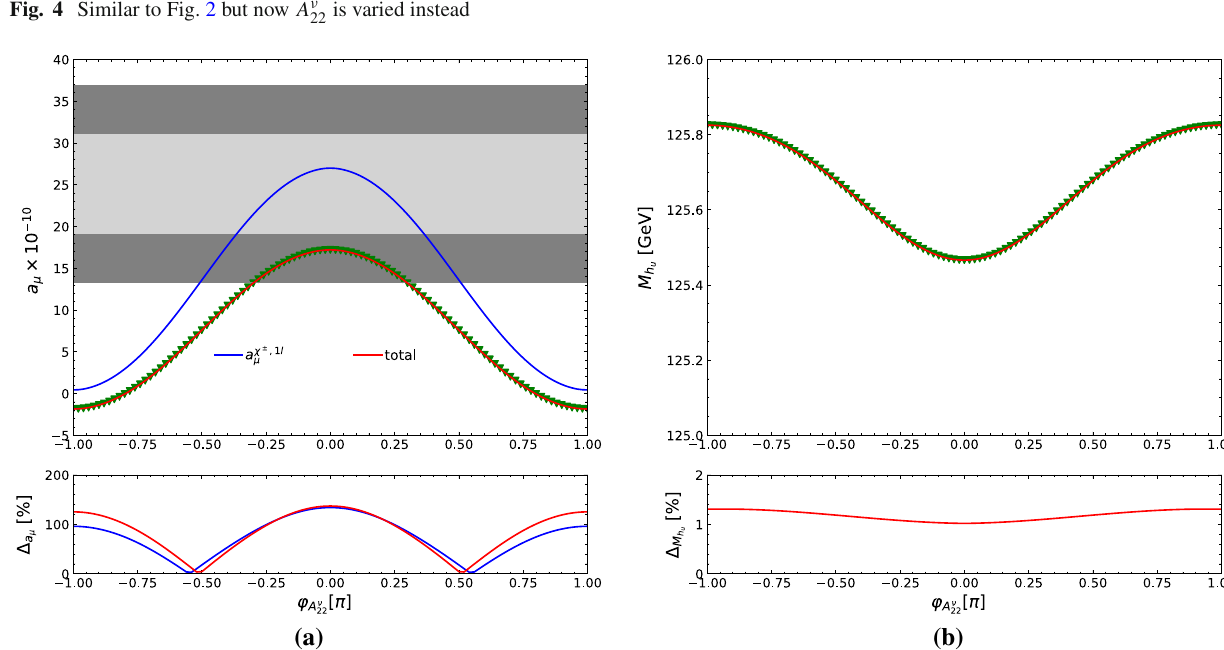
Fig. 4 Similar to Fig. 2 but now A ν